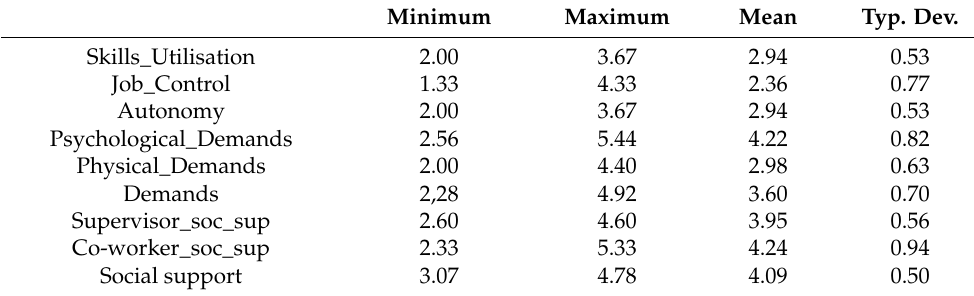
Table 11. Work demands and